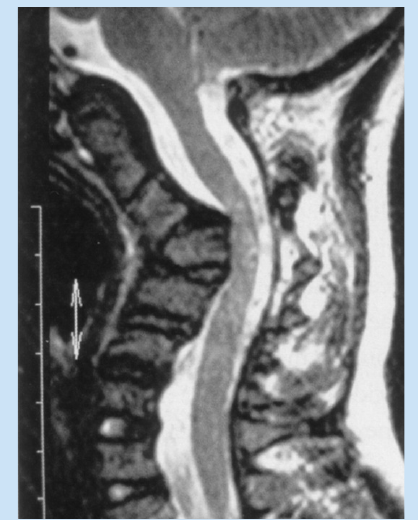
Fig 1a. Sagittal T2-weighted MR images showing the focal gibbus at the C2, C3 and C4 levels. The canal is narrowed at this level but no cord hyperin- tensity is seen.